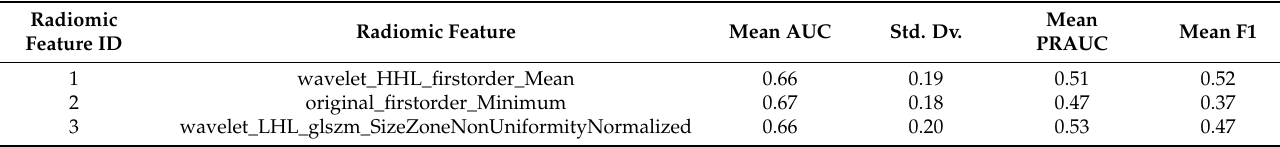
Figure 1. Radiomic heat map shows unsupervised clustering of all patients. The patients were clustered into 2 clusters based on the similarity of their radiomic feature patterns. The standardized z-scores were used to depict the normalized feature value variation for the patients. Table 2. Three radiomics features of 841 selected from each segmented tumor. Univariate AUCs and PRAUCs for the three radiomics features are listed. AUC: area under ROC curve; Std. Dv.: standard deviation; PRAUC: area under the precision-recall ROC